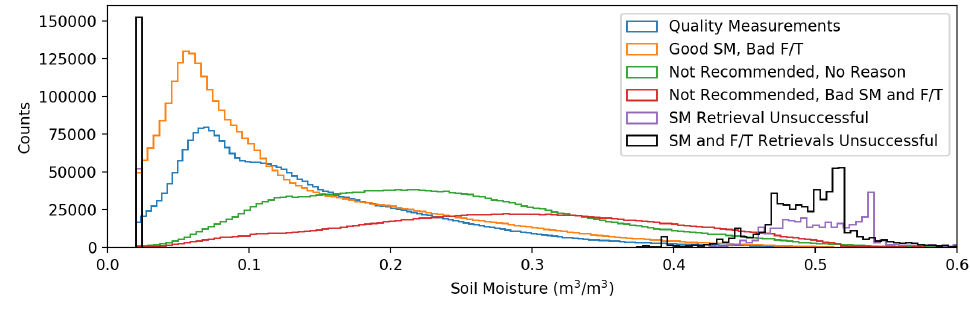
Figure 4. SMAP quality flag distributions with soil moisture. Large spike at low values from black/purple